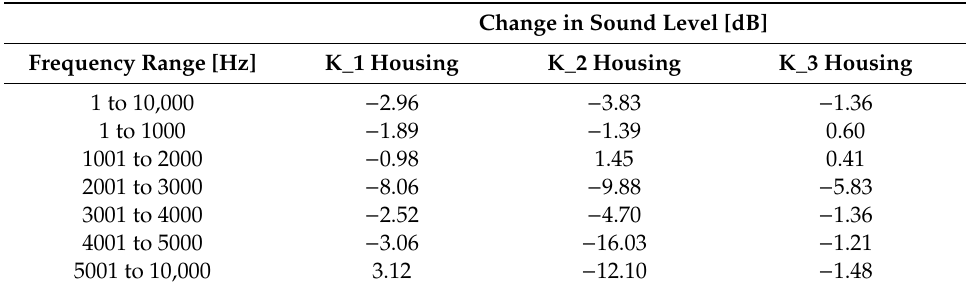
Table 4. Change in the sound level of housings K_1–K_3, relative to the steel